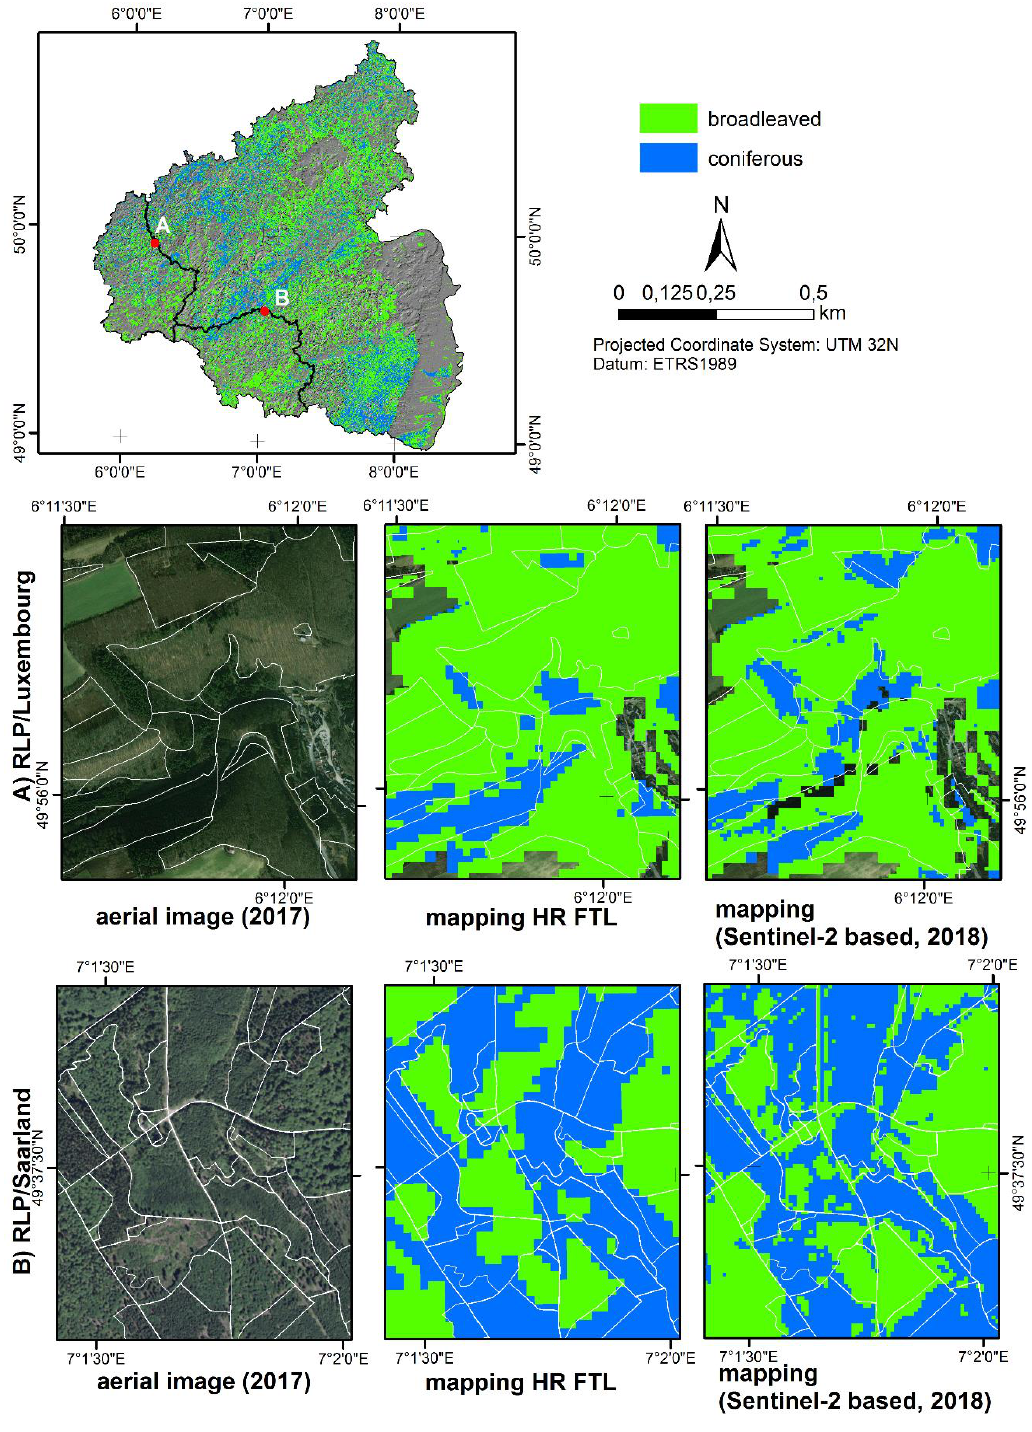
Figure 8. Mapping of the Copernicus HR-FTL and the Sentinel-2 based prediction map in the border region of Luxembourg and RLP and the border region of RLP and the Saarland.